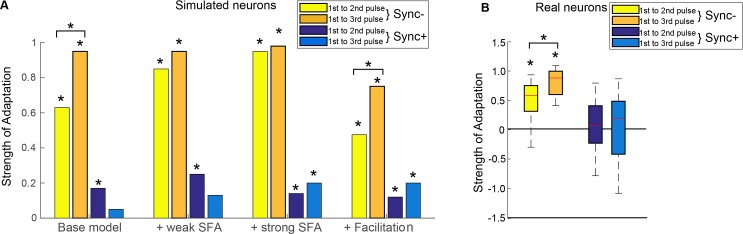
Adaptation between individual acoustic events for real neurons and different models.(A.) Adaptation between the 1st and 2nd input, and between 1st and 3rd input for Sync+ and Sync- neurons for models with different adaptation mechanisms. Strength of adaptation increased significantly between 1st to 2nd pulse and 1st to 3rd pulse for Sync- base and facilitation model (Wilcoxon signed rank test P << 0.001) (B.) Strength of adaptation in real Sync+ and Sync- neurons between the 1st and 2nd input, and between 1st and 3rd input. Strength of adaptation increased significantly between 1st to 2nd pulse and 1st to 3rd pulse for Sync- neurons (Wilcoxon signed rank test P <0.01). Asterisks directly above bars indicate that the adaptation amplitude was significantly different from 0 (Wilcoxon signed rank test P <0.05).